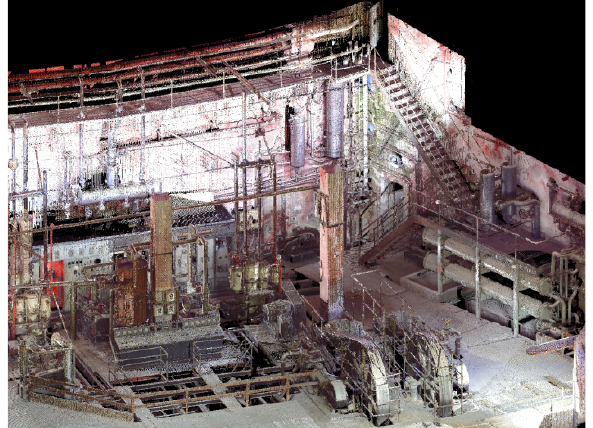
Figure 11. 3-D view of point clouds of a part of the machine room.